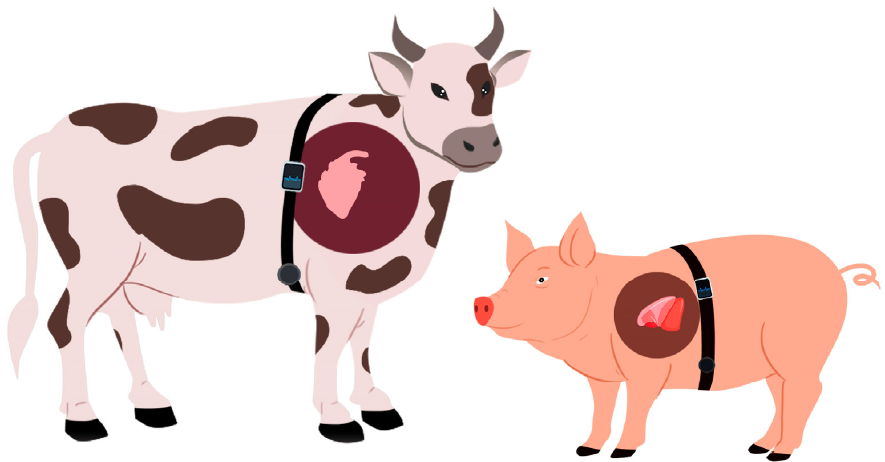
Figure 3. Graphics indicating best locations for deployment of the non-invasive wearable patch on the surface of the body parts of the cows and pigs. The pig’s heart is in the thoracic cavity nestled between the lungs on the body’s midline. For the dairy cow, along the median plane of the body, 5/7 of the heart are in the left half of chest cavity while only 2/7 on the right half. Circles indicate the tentative region of the body for positioning the electrode of the sensor patch on the body of the farm animals.